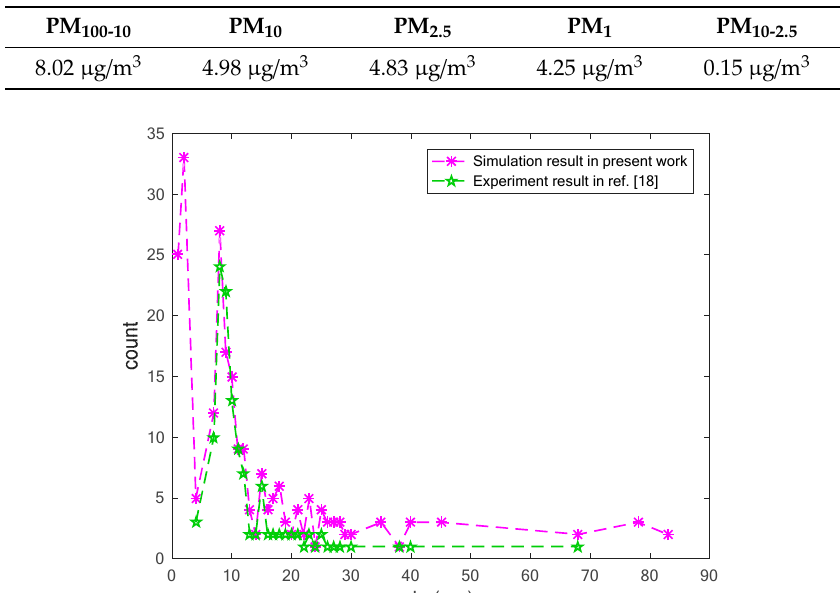
Table 2. Atmospheric particulate matter concentration.